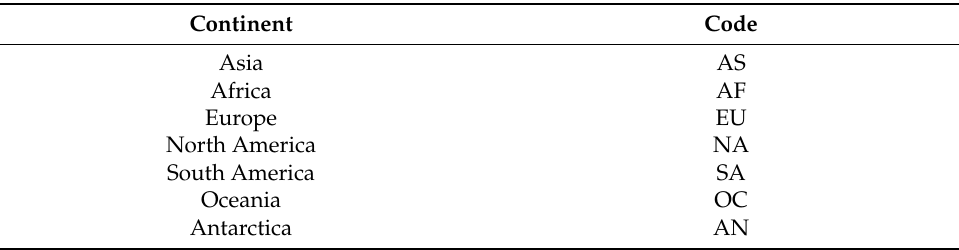
Table 1. List of all continents and codes to be used in the G base. Continent Code Asia AS